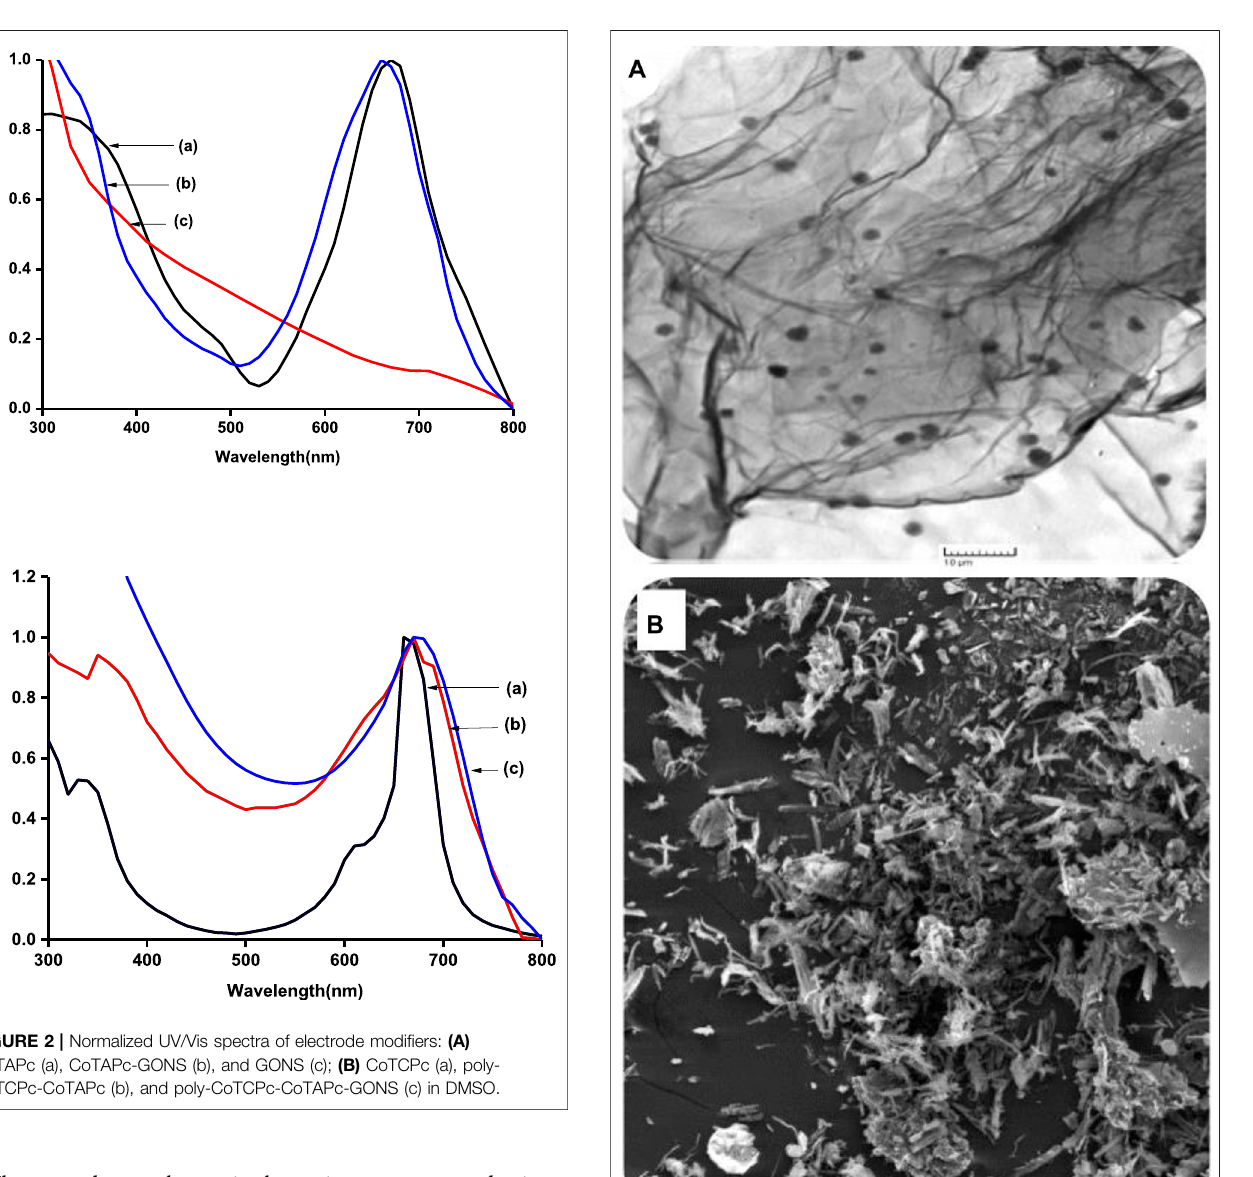
Frontiers in Chemistry |